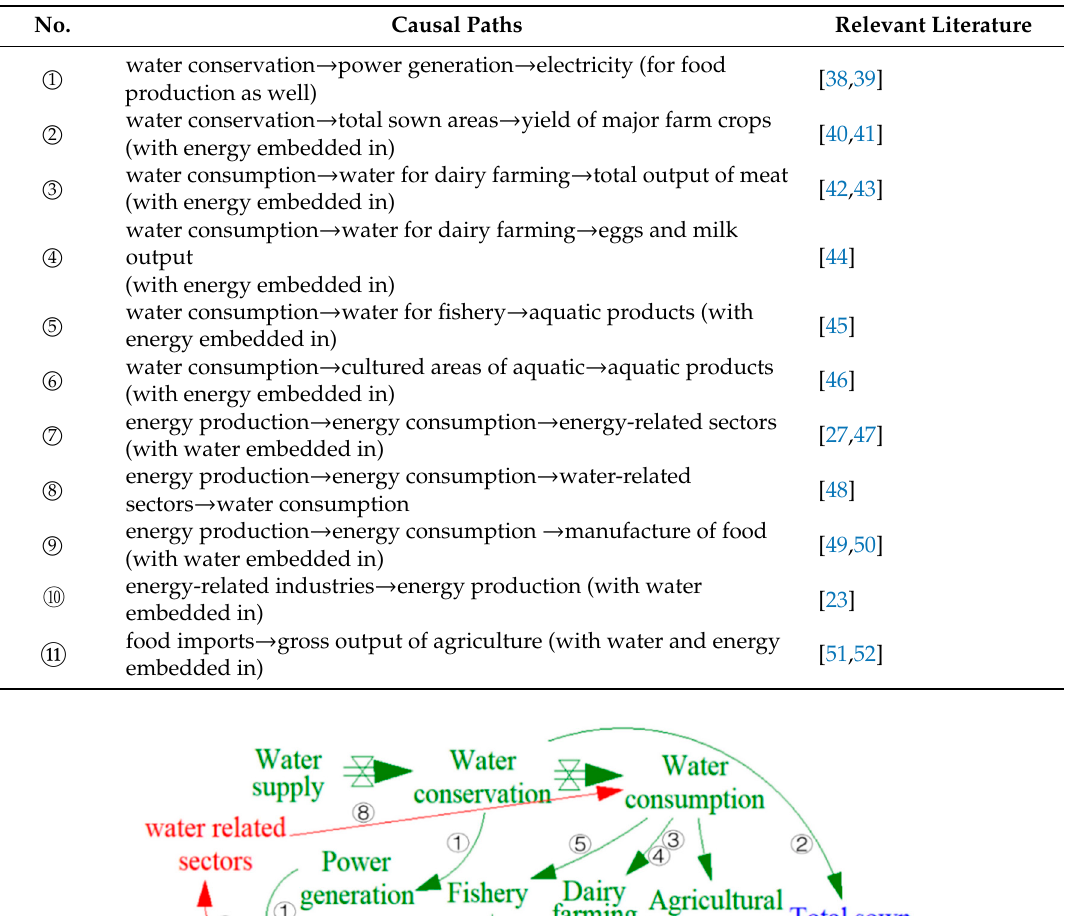
Table 2. Causal paths of order parameters examined by literature.